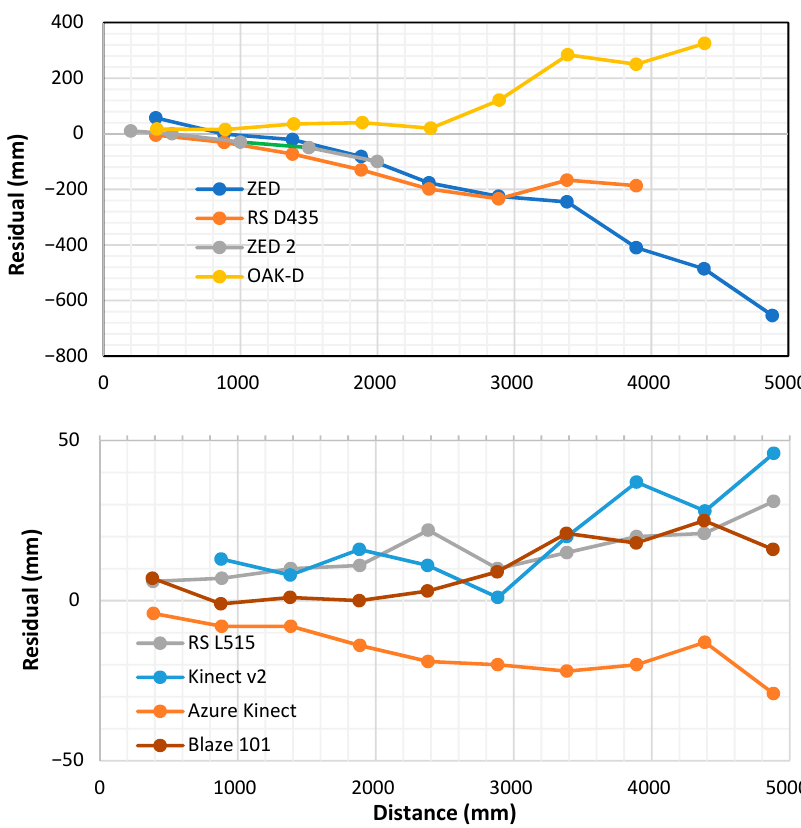
Figure 3. Residuals on measurement of camera-to-object distance. Top panel: ZED, RS D435, ZED 2 and OAK-D depth cameras; Bottom panel: RS L515, Kinect v2, Azure Kinect and Blaze 101 depth cameras. The test object was a 110 mm square ceramic tile, with imaging under room lighting.